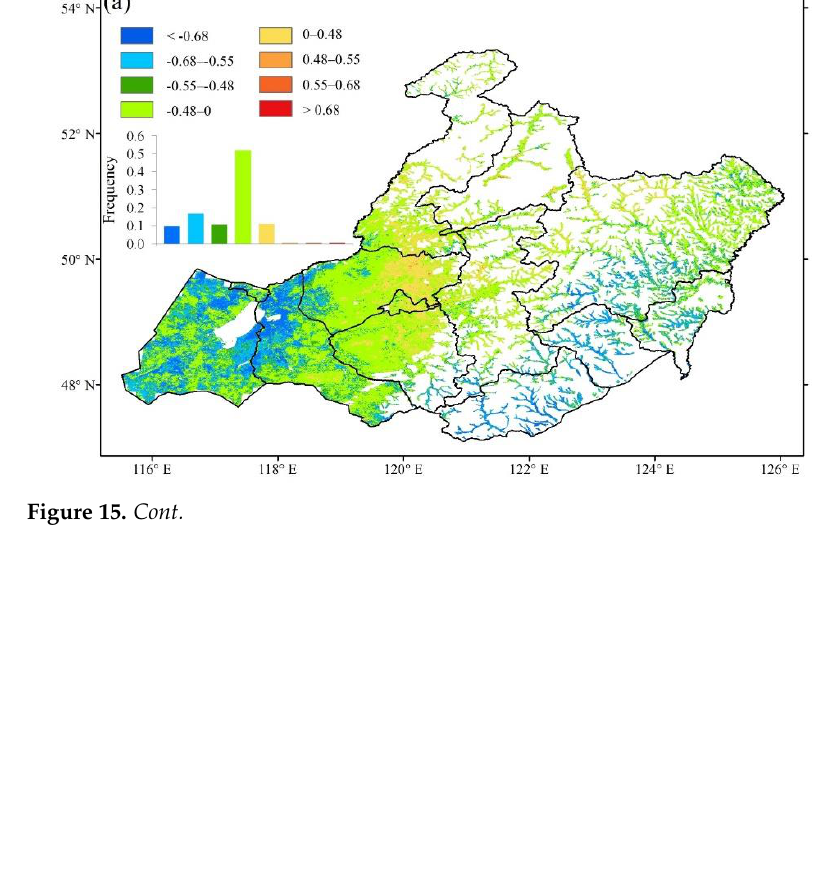
Figure 15. Spatial patterns of the interannual partial correlations between the accumulated grow- ing degree-days requirement and chilling days ( a ), precipitation ( b ), and insolation ( c ) under the 5 °C threshold 60 days before the green-up date. Partial correlation coefficient values of ±0.68, ±0.55, and ±0.48 correspond to significance at p = 0.01, p = 0.05, and p = 0.10, respectively. Top-left insets show the frequency distributions of the correlation coefficients corresponding to the values indi- cated by the map legends.